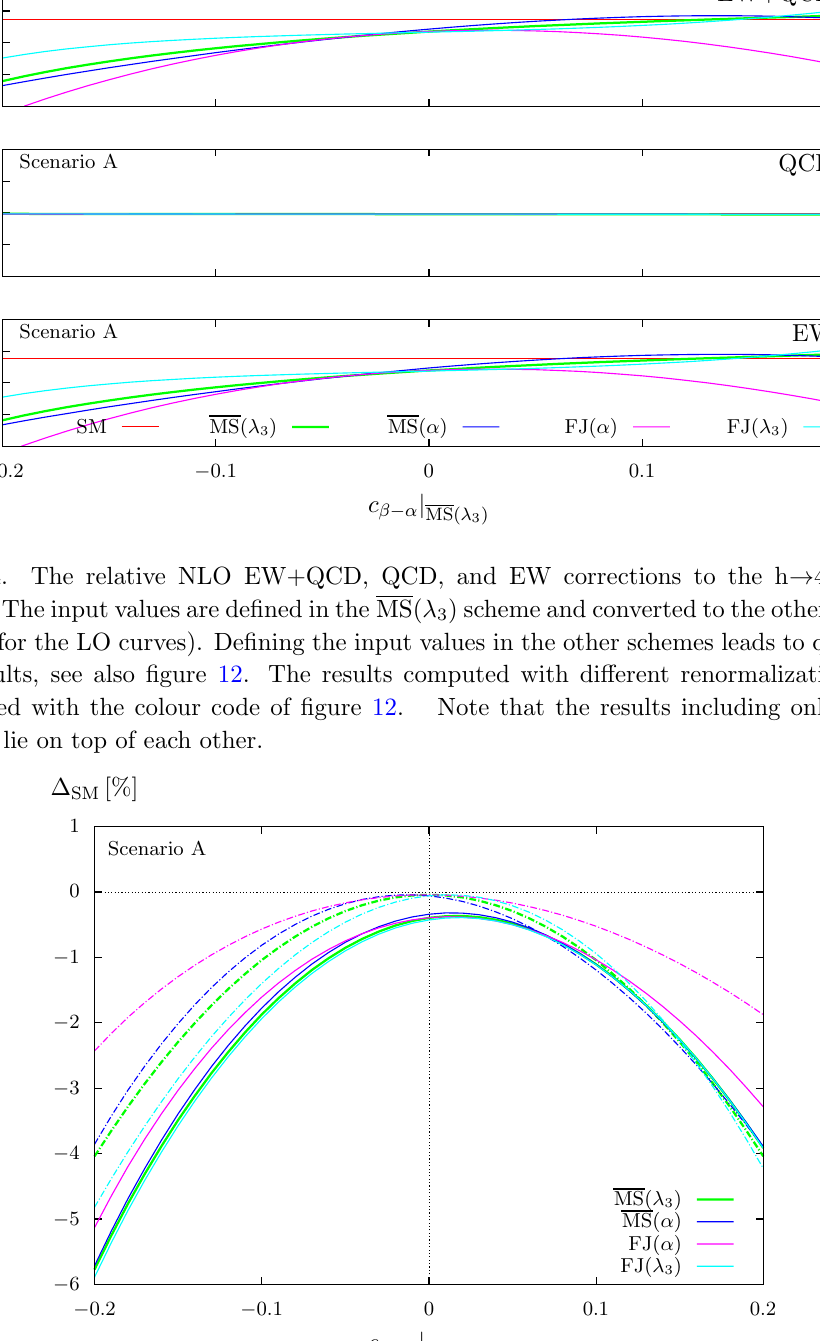
Figure 15 . The relative di(cid:11)erence of the h 4 f decay width in the THDM w.r.t. the SM prediction ! at LO (dashed) and NLO EW+QCD (solid). The input scheme is MS( (cid:21) 3 ), and the corrections are computed in all four renormalization schemes after converting the input at NLO (also for the LO curves), which are displayed using the colour code of (cid:12)gure 9.